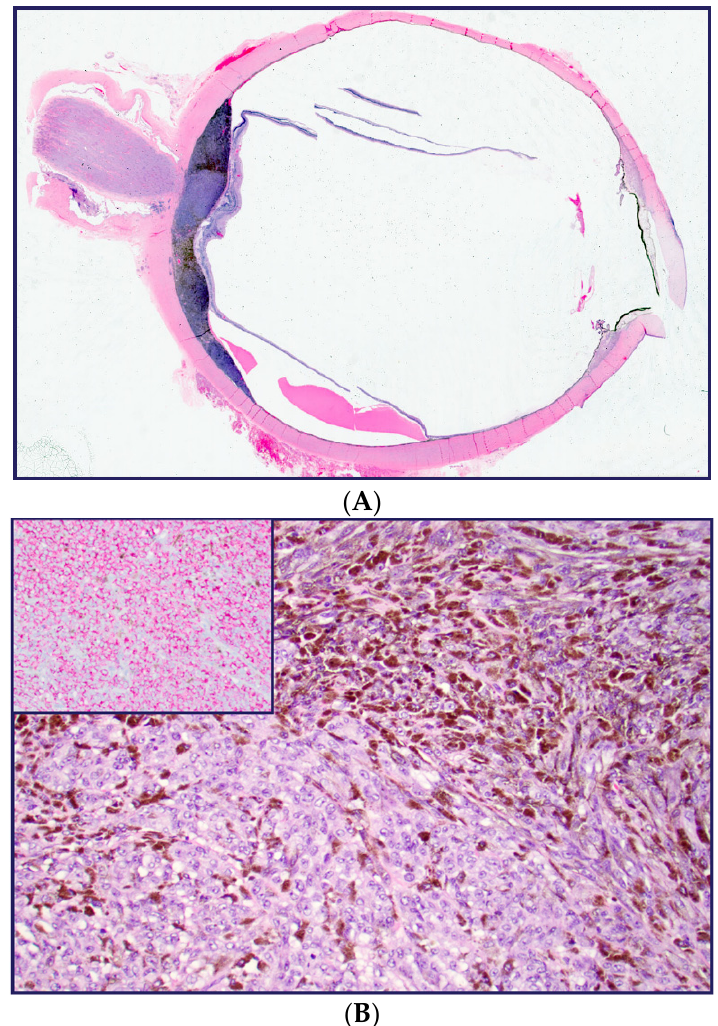
Figure 1. Melanoma from patient #1 without extrascleral extension ( A ). The tumor assumes a primar- ily epithelioid morphology ( B ), with the expression of HMB45 in malignant melanocytes